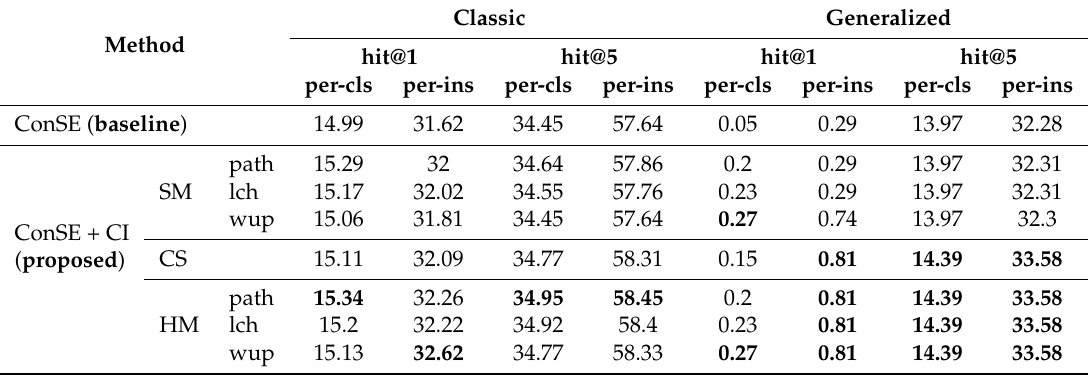
Table 5. Evaluation results for the proposed methods with the YOLOv2-80 detector on Visual Genome categories.